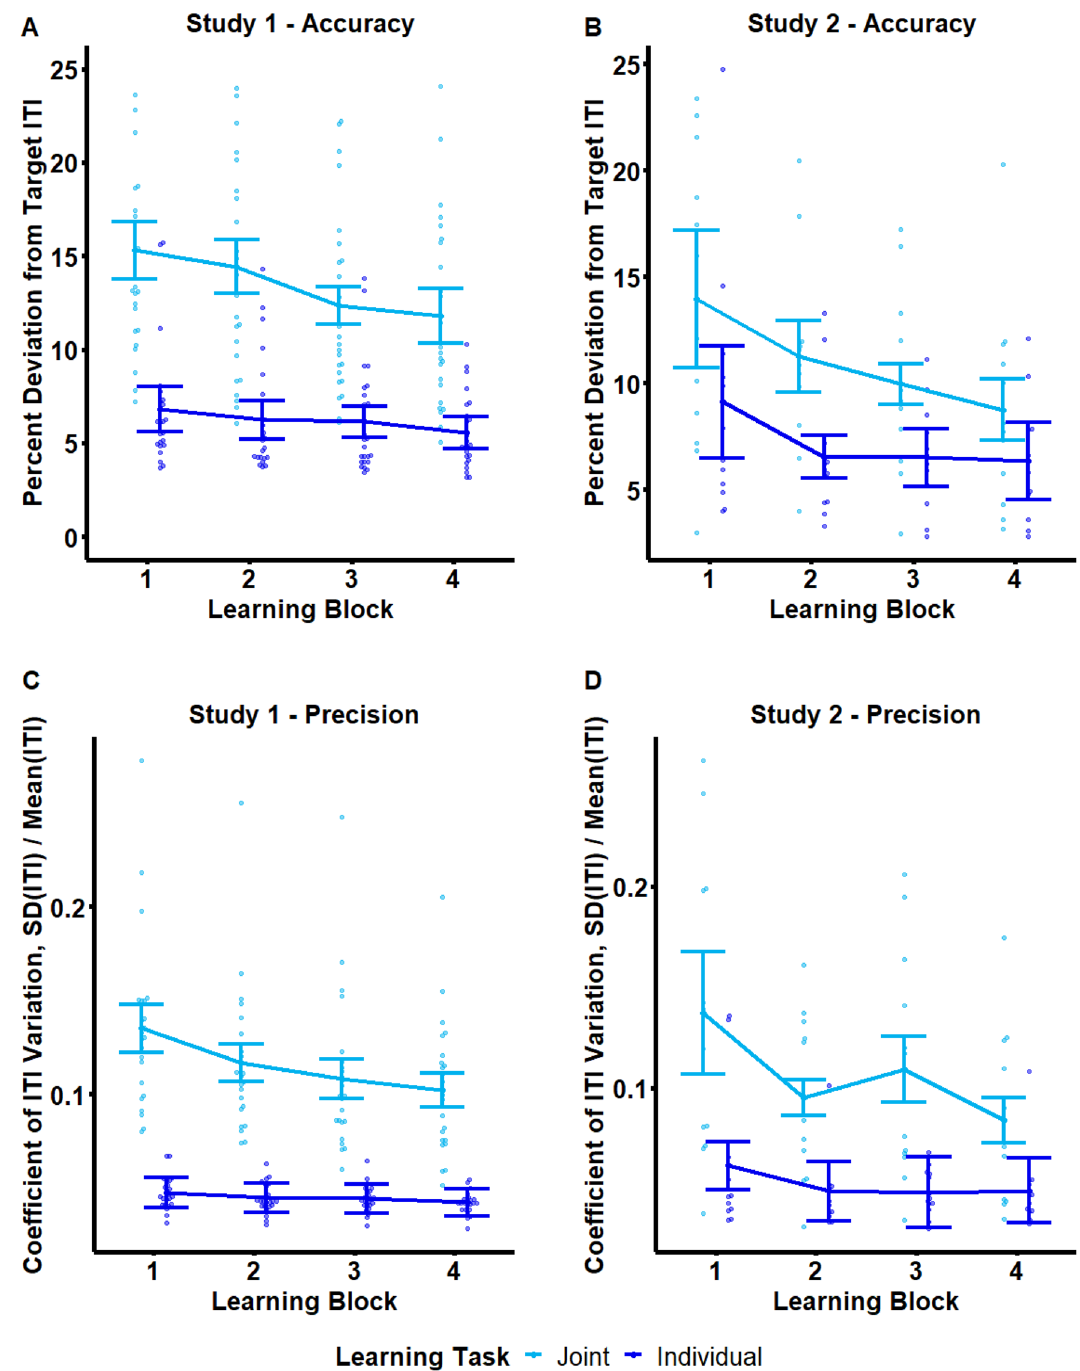
Figure 2. ITI Precision & Accuracy. Top row: Mean ITI accuracy (percent deviation from metronome- cued ITI) across Learning Blocks for Studies 1 (Panel A) and 2 (Panel B). Bottom row: Mean ITI precision (Coefficient of Variation, CV(ITI)) across Learning Blocks for Studies 1 (Panel C) and 2 (Panel D). In all panels, Individual and Joint tasks are displayed in dark and light blue respectively, and error bars reflect within-subject 95% Confidence Intervals